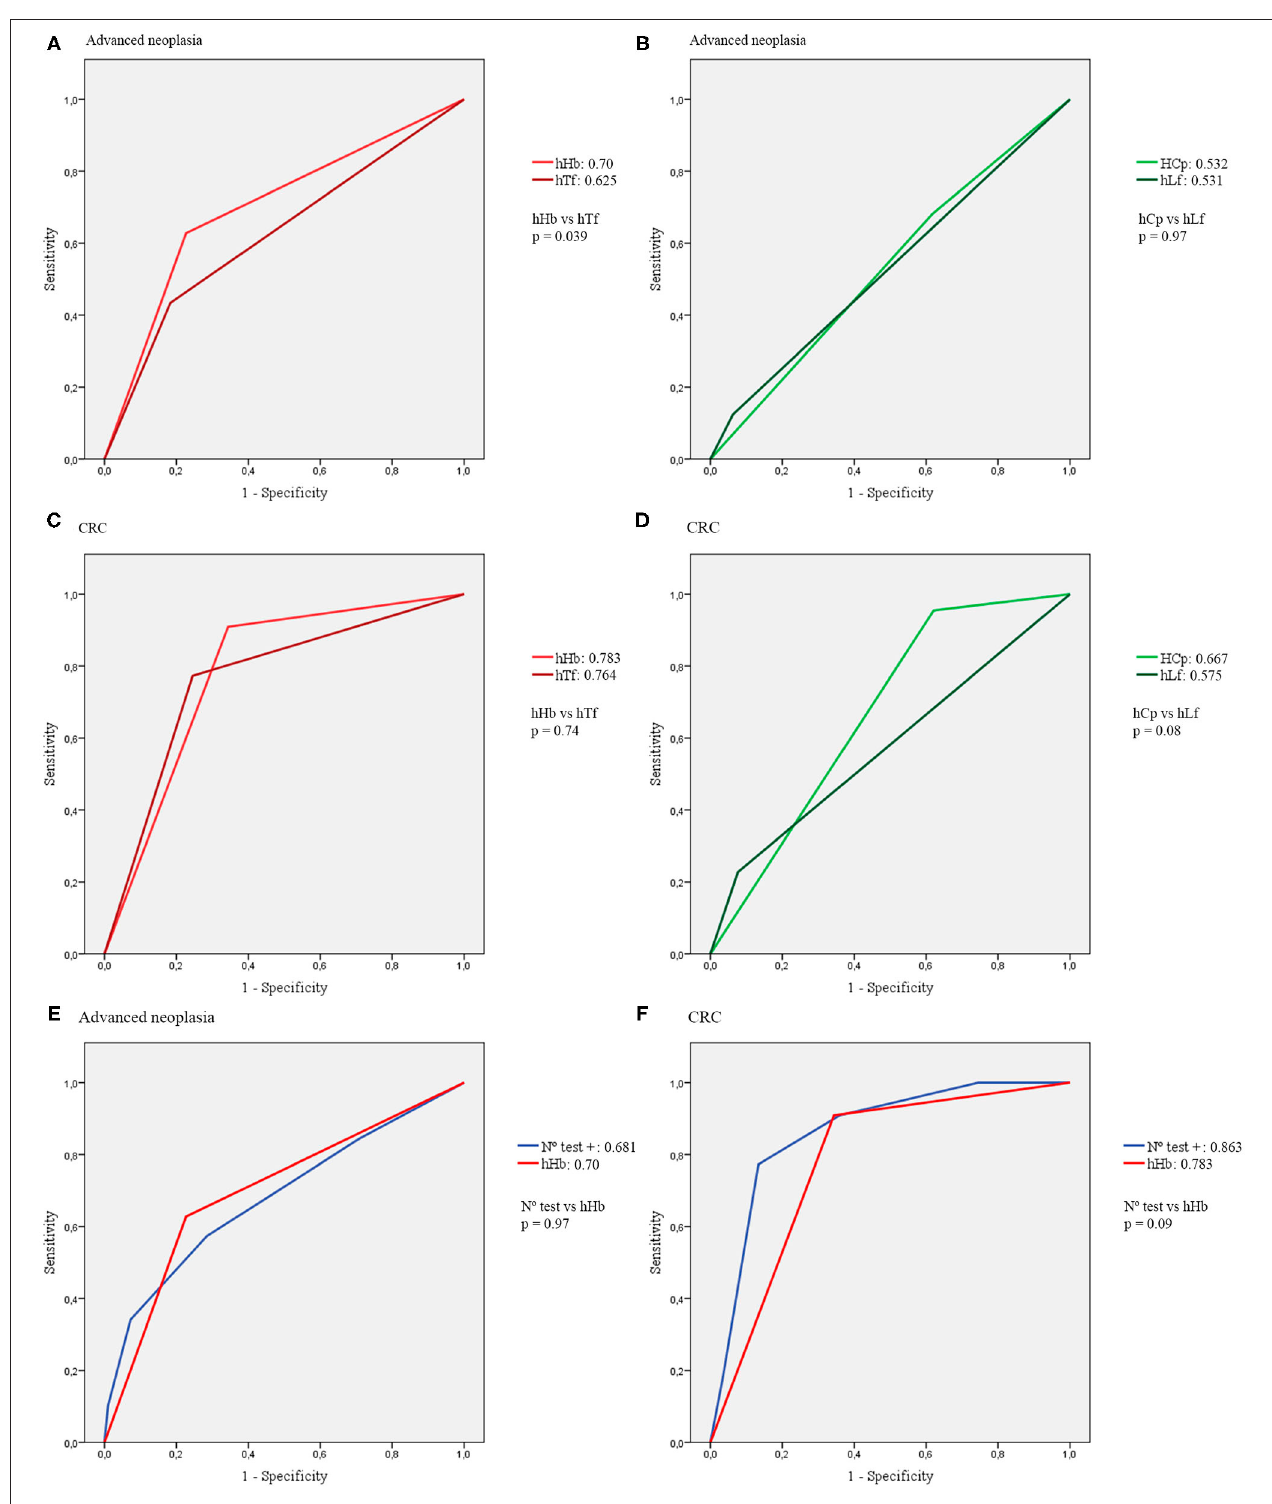
FIGURE 2 | AUCs of the four biomarkers of the combo test. (A) AUCs of hHb and hTf for advanced neoplasia. (B) AUCs of hCp and hLf for advanced neoplasia. (C) AUCs of hHb and hTf for CRC. (D) AUCs of hCp and hLf for CRC. (E) AUCs of the combo test compared with hHb for advanced neoplasia. (F) AUC of the combo test compared with hHb for